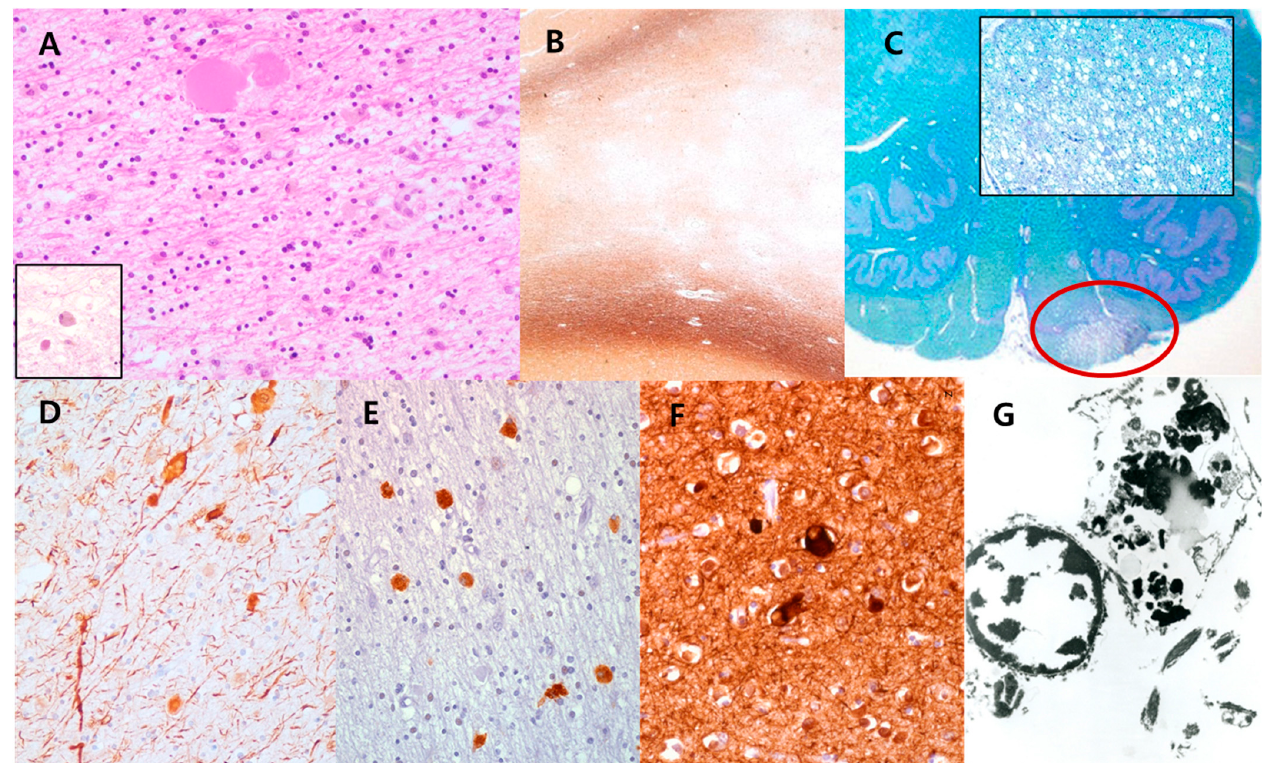
Figure 2. Histopathological findings of the brain in case 1. ( A ) The white matter lesions revealed scattered axonal spheroids and pigmented macrophages (inset) on hematoxylin-eosin stain (×200), and ( B ) extensive loss of myelinated axons with sparing of subcortical U-fibers on Bielschovsky’s silver staining (×40). ( C ) The unilateral corticospinal tract (red circle) was also affected by the loss of myelinated axons or pigmented macrophages (LFB, scan view; inset: LFB, ×200). Immunohisto- chemically, ( D ) axonal spheroids and pigmented macrophages were positive for phosphorylated neurofilaments (NF) (×200) and ( E ) CD68 (×400), respectively. ( F ) A few ballooned cortical neurons were stained with phosphorylated NF (×400). ( G ) Ultrastructurally, the pigmented granules in mac- rophages exhibited lipofuscin ceroids (×7000).